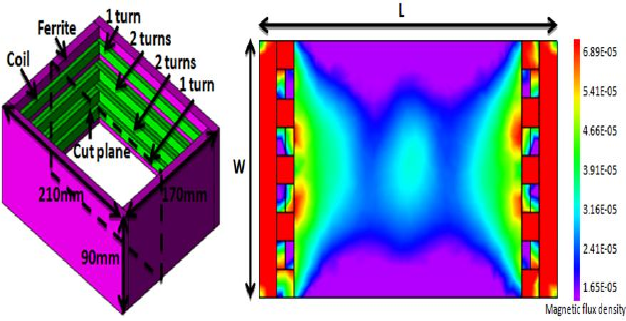
Figure 4: Vertical field box MFD